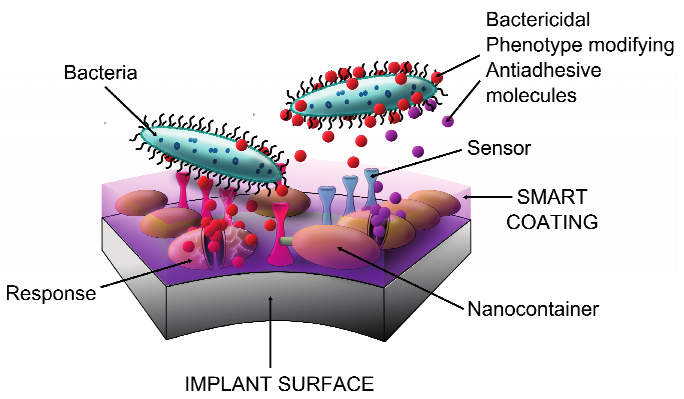
Figure 7. Smart coatings continuously screen the local effective space using molecular receptors specific to a surrounding target’s signals. Stimulation of target-sensitive receptors triggers a cascade of events resulting in outflow of specific substance(s) that affect the